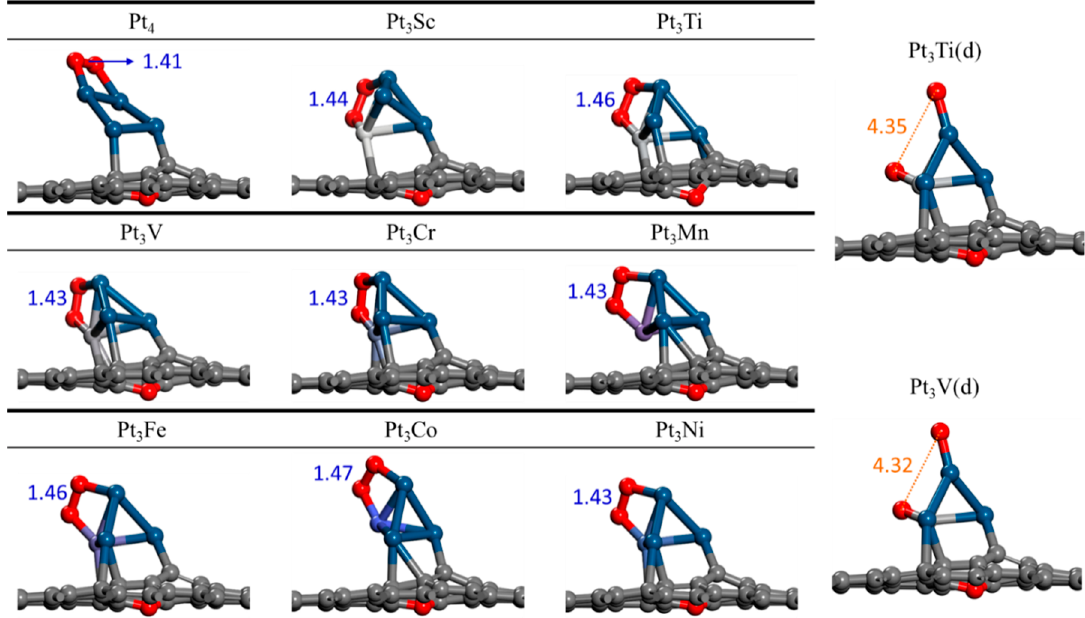
Figure 2. Adsorption configuration and O–O bond distance (shown in Å) of O 2 on OG–Pt 3 M. The left three columns show O 2 adsorbed as di-oxygen species, while the two structures on the right are the O adatoms on supported Pt 3 Ti and Pt 3 V. Red, dark blue, and grey spheres represent O, Pt, and C, respectively. The color of M is different and depends on the element.